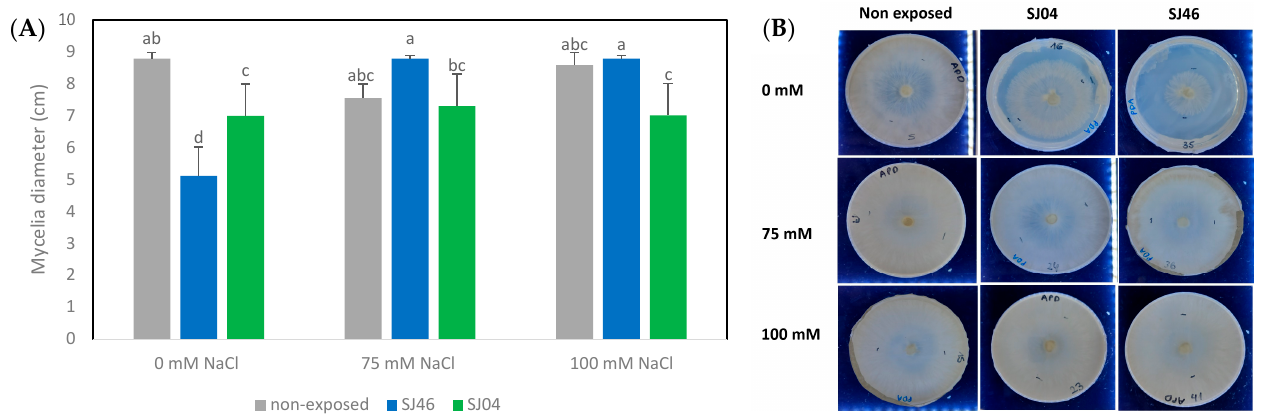
SJ04 grown under 75 and 100 mM NaCl did not modify the mycelia diameter of S. rolfsii ( p > 0.05).